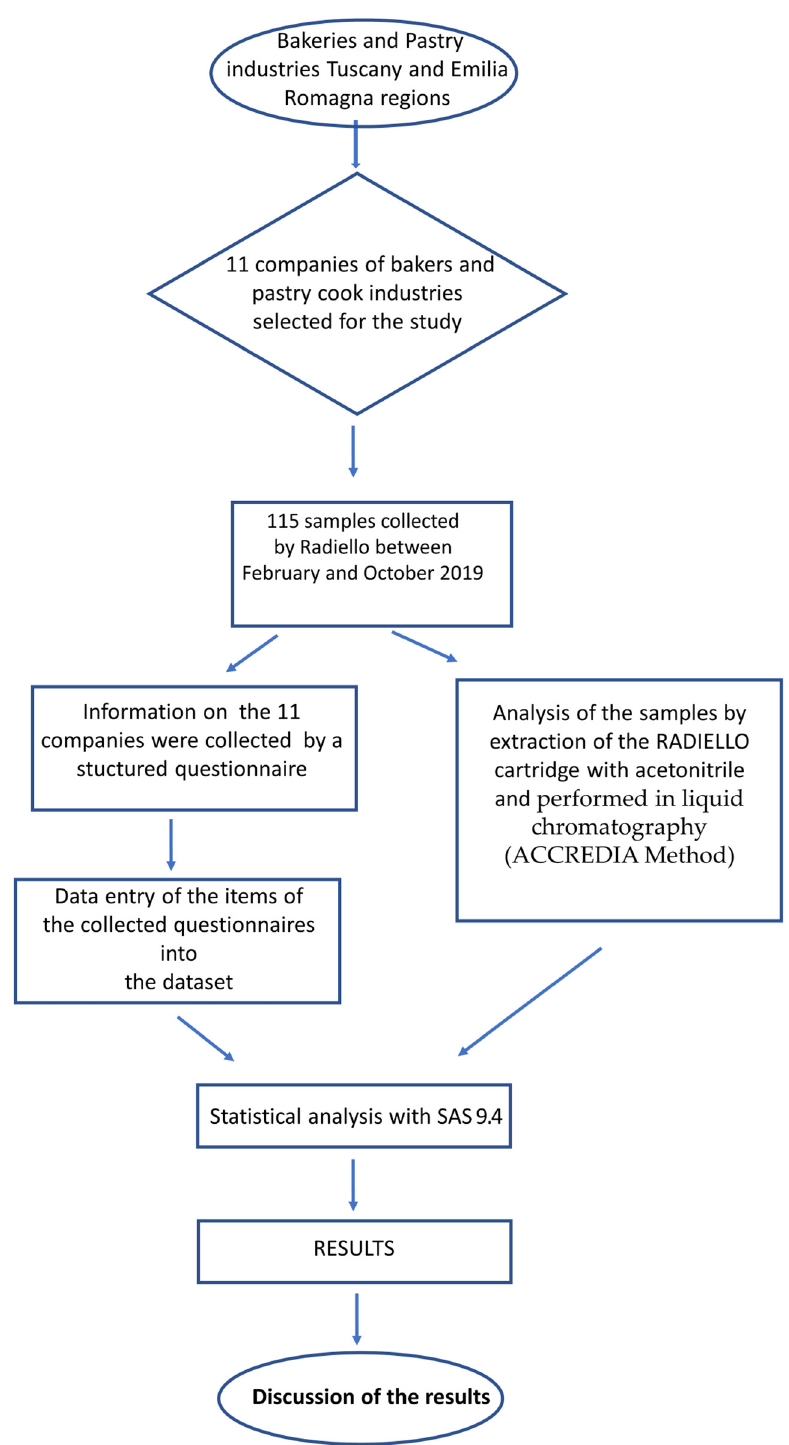
Figure 1. workflow